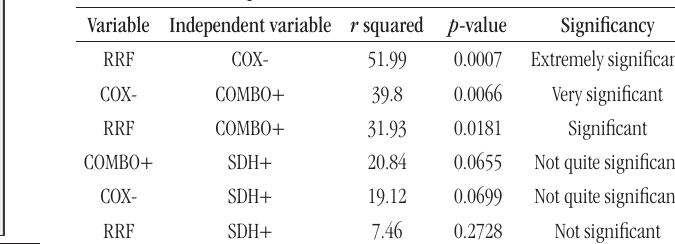
taBLE 3 − Multiple regression for four events (%) from 18 muscle biopsies with mitochondrial abnormalities